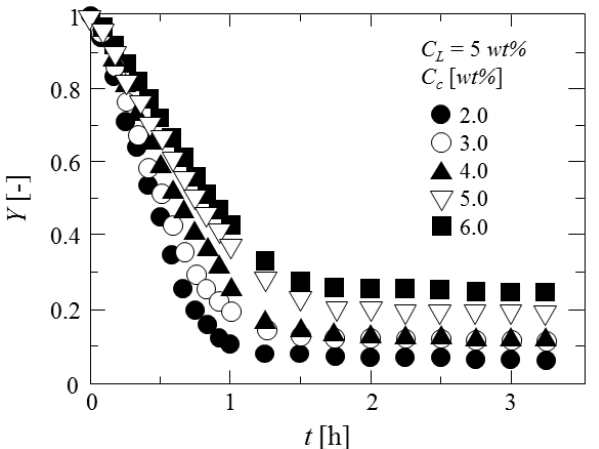
Figure 13. Drying feature of